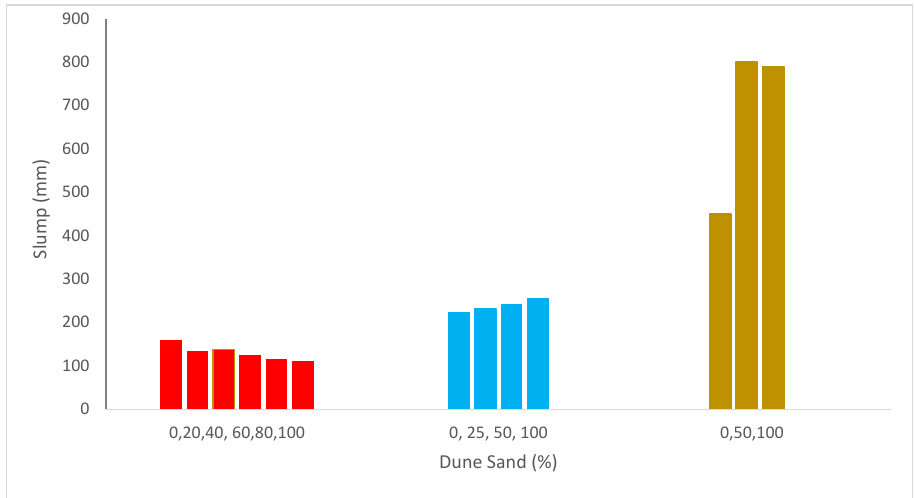
Figure 3. Slump flow: data source [40,48,58].